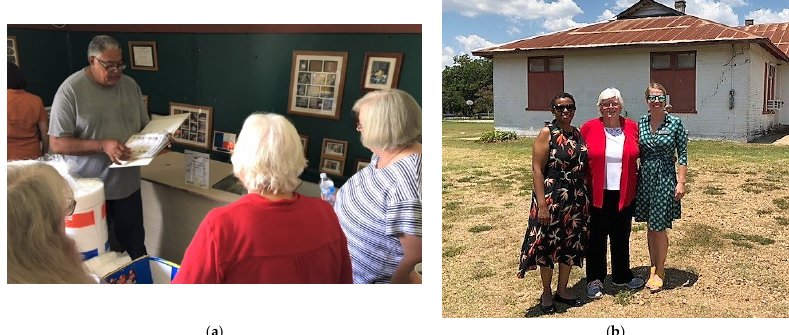
Figure 3. The CLG Workshop, held 1 August 2018, was co-hosted by the state CLG program, the County Historical Commission, and the Edwards Association—a local African American group dedicated to the preservation of a historic African American School in Gonzales. ( a ) Edwards Association director, David Tucy, leads a tour through the historic school during lunch. ( b )Pictured l. to r. Workshop presenter, Glenda Gordon, and Madeline Clites, Texas Historical Commission (THC)-CLG program manager. All images by Texas Historical